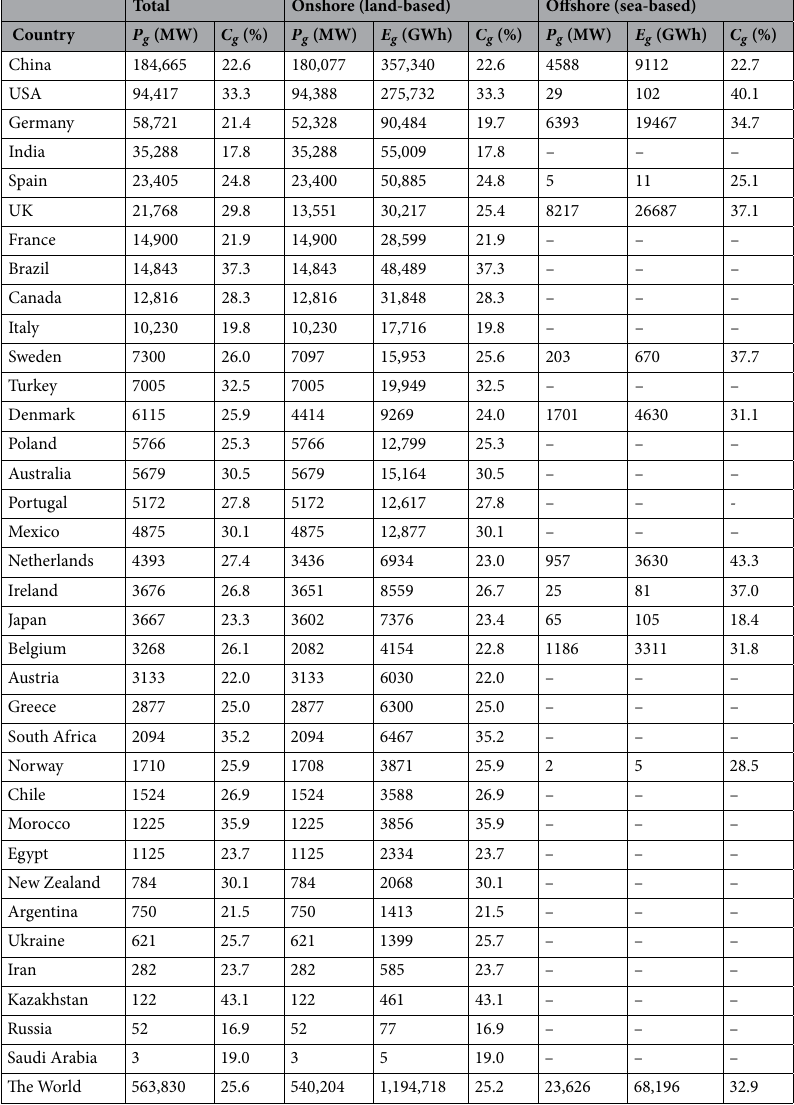
Table 10. Wind power capacity factor for 2018 by country with the installed rated power retrieved from the Our World in Data database 47 .